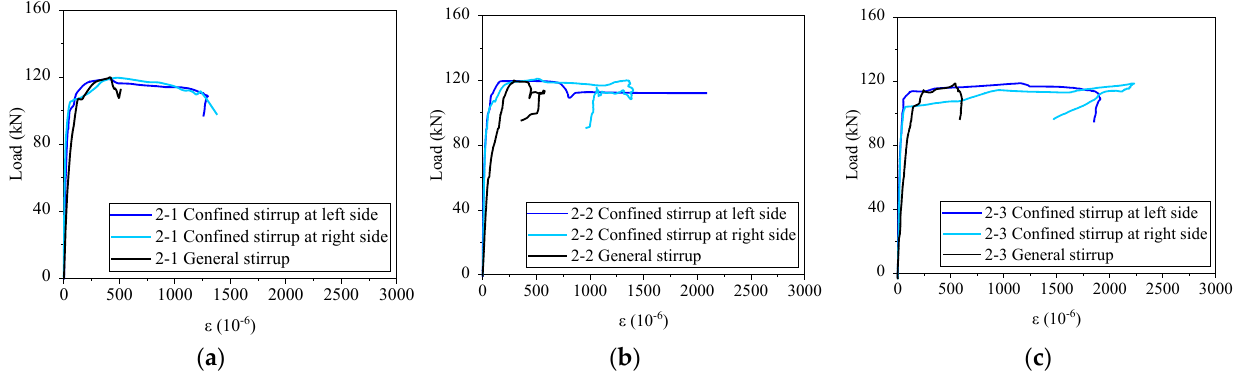
Figure 15. Strain development of stirrup ( a ) M4-D12-7.5d-1; ( b ) M4-D12-7.5d-2; ( c )